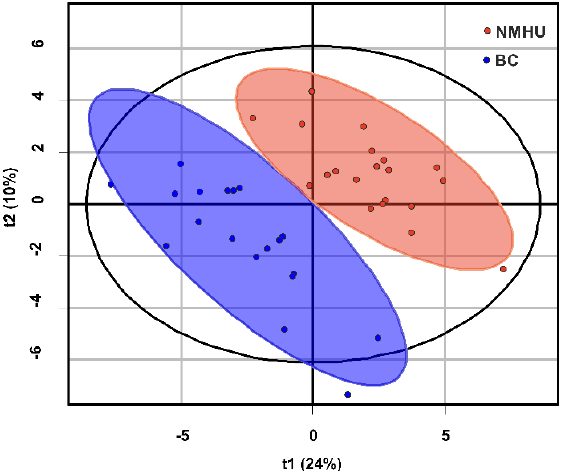
Figure 3. PLS-DA score plot (patients with bladder cancer (blue), patients with non-malignant hematuria (red); dots represent the metabolomics profile of the urine of an individual subject).